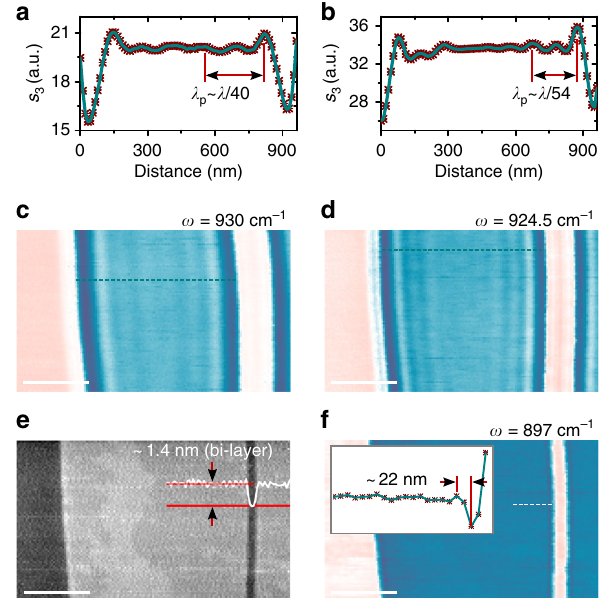
Fig. 3 Highly con fi ned SPhPs on bi-layer MoS 2 – SiC structure. a – d Near- fi eld images ( c , d ) and corresponding cross-sections ( a , b ) along cyan dotted lines, recorded at ω = 930 and 924.5 cm − 1 . e AFM topography of the sample. Inserted white pro fi le shows the height variation along the bottom red line. f Near- fi eld image at ω = 897 cm − 1 . Inset in image ( f ) shows cross-section of the near- fi eld signal along the dotted white line. Scale bars are 400